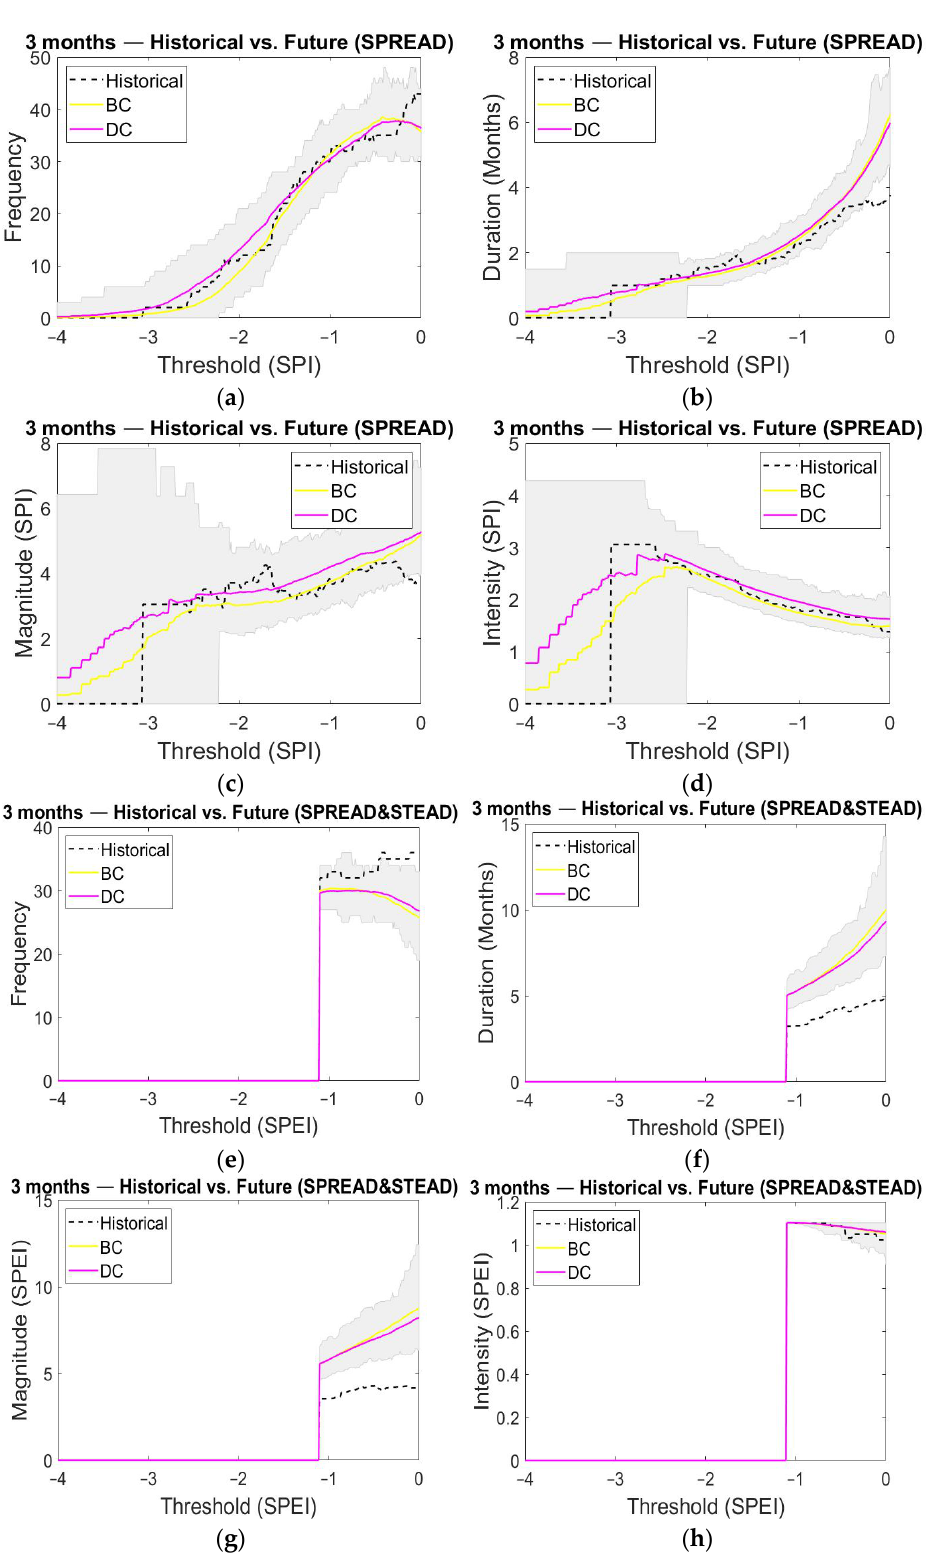
Figure 9. Historical and future meteorological drought ( a ) frequency; ( b ) mean duration; ( c ) mean magnitude; ( d ) mean intensity derived from SPI for the 3 months temporal-aggregation scale (Spain02 database). Historical and future meteorological drought ( e ) frequency; ( f ) mean duration; ( g ) mean magnitude; ( h ) mean intensity derived from SPEI for the 3 months temporal-aggregation scale (SPREAD and STEAD